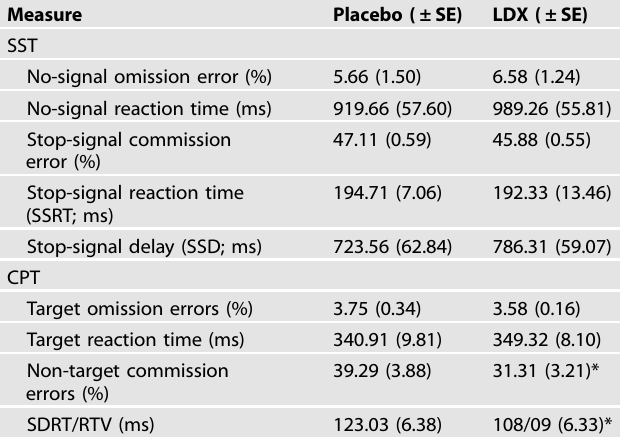
Table 1. Stop-signal task (SST) and continuous performance task (CPT) results.